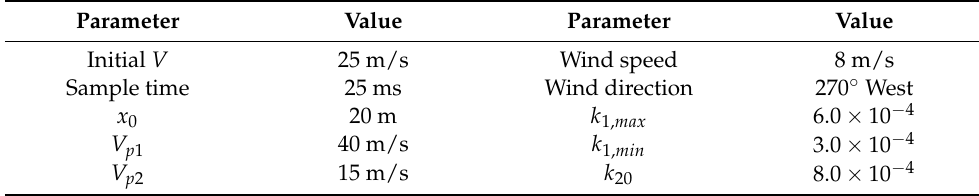
Table 2. The parameters for